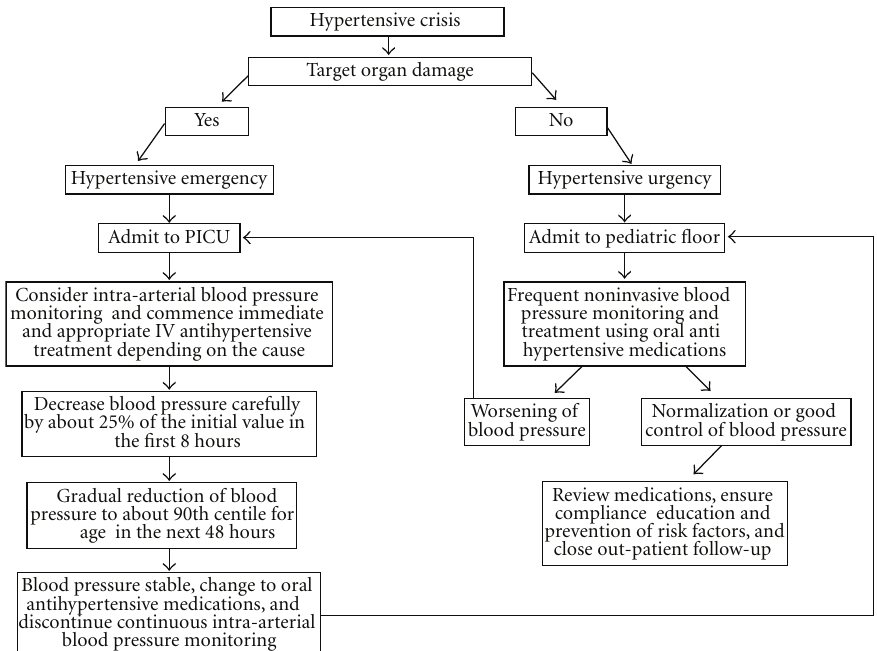
Figure 3: Proposed algorithm for the management of hypertensive crisis in